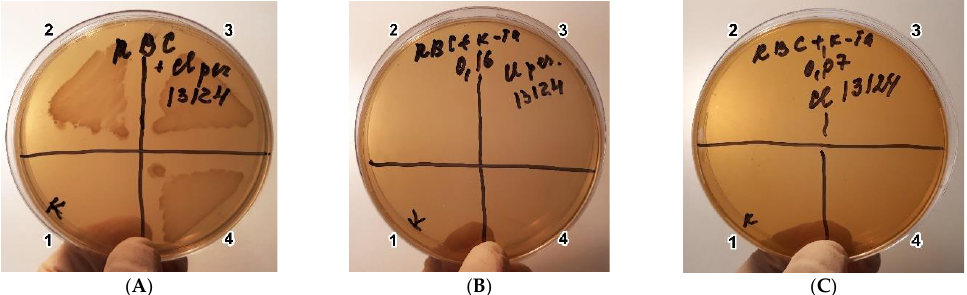
Figure 3. Bactericidal properties of lauric acid against the toxin-producing strain C. perfringens 13124 in in vitro experiments (( А )—control without LA: 1—sector without test-strain (for control of medium sterility), 2, 3, 4—sectors inoculated with test-strain; ( B )—test with addition of LA at 0.16 g/L; ( C )—test with addition of LA at 0.07 g/L: 1—sector not seeded with the test strain, 2, 3, 4—sectors seeded with the test strain (no growth of the test strain)). Table 3. Growth suppression of C. perfringens strains by lauric acid at different concentrations.